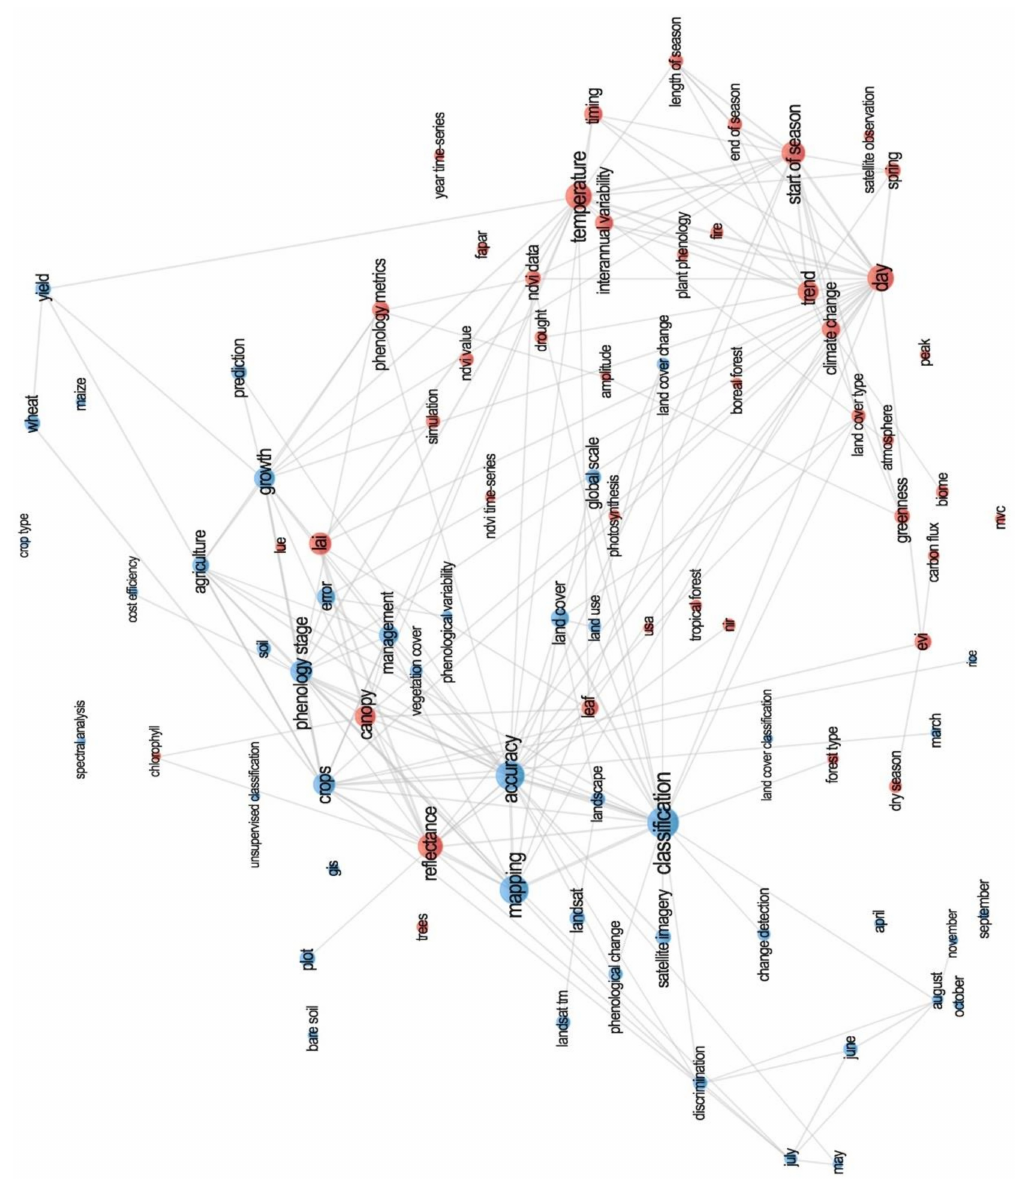
Figure 5. Network mapping and clustering of terms in 1999–2008. Since it is a 3-d map, not all the terms are represented. Lines represent the link strength between two terms (minimum link strength = 10). Red cluster = phenology / climate topic; Blue cluster = classification / agriculture